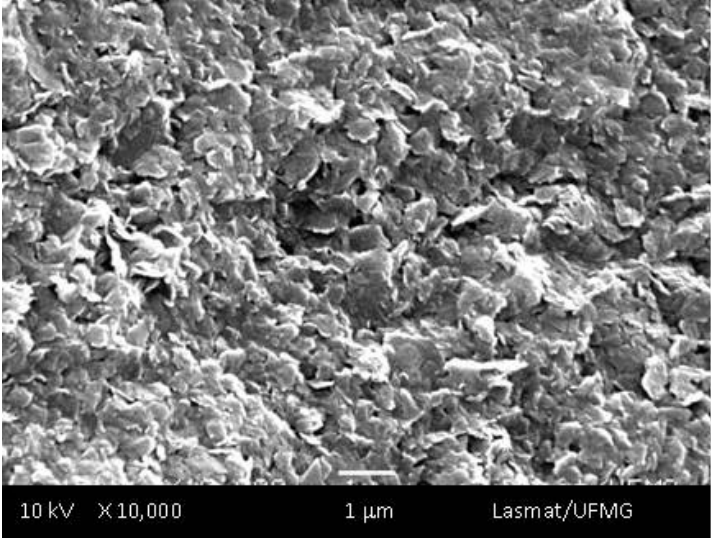
Figure 2. SEM image of UHMWPE surface used as reference prior to oxidation showing a “wave-like” morphological